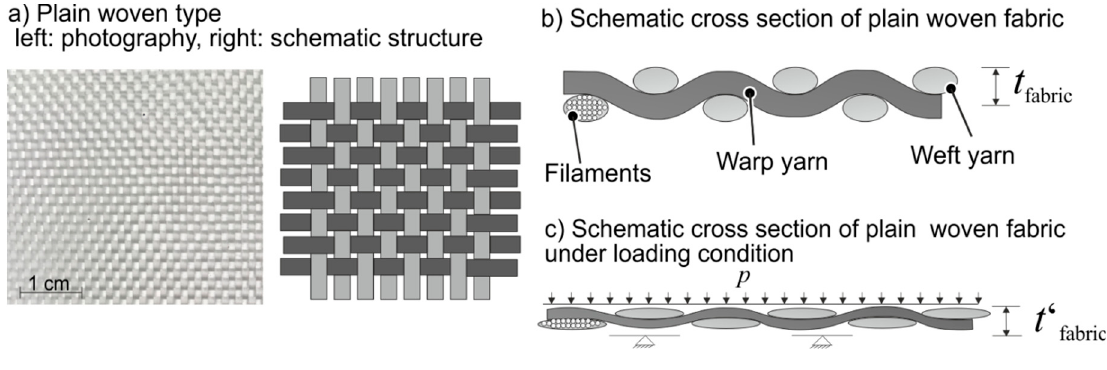
Figure 3. Geometry of plain woven fiber: ( a ) structure; ( b ) cross-section unloaded; ( c ) cross-section loaded.